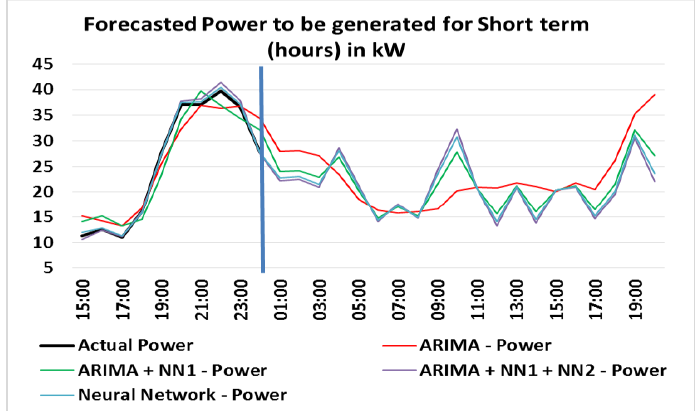
Figure 11. Generated power expected. Short-term (hours) in KW.